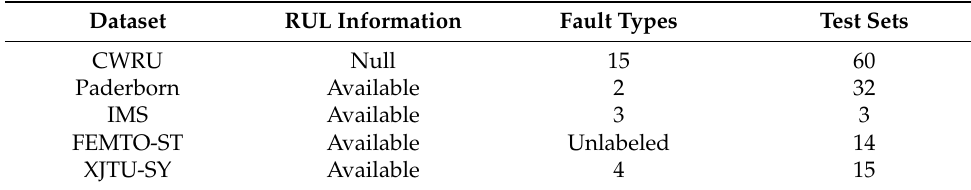
Table 1. Overview of public datasets on